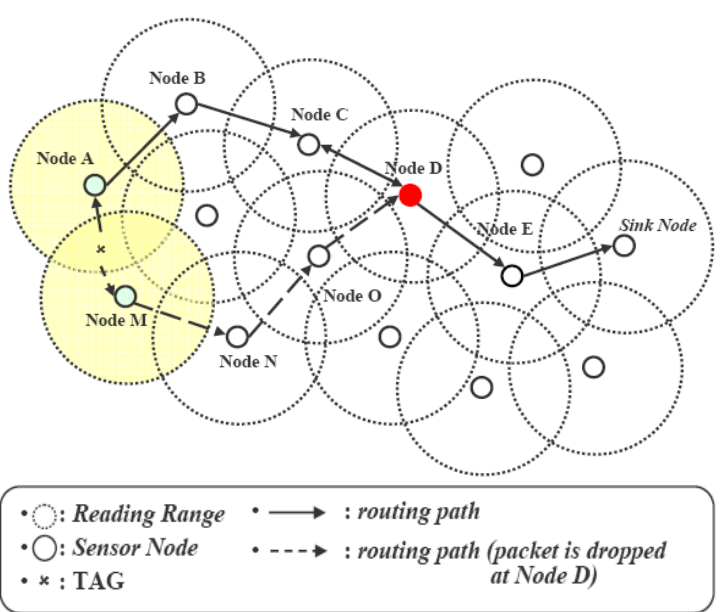
Figure 2. Filtering the data at a distant